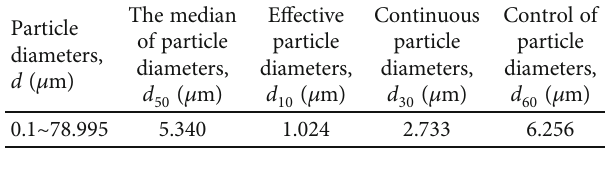
Table 4: Di ff erent particle diameter indices of the sediments.